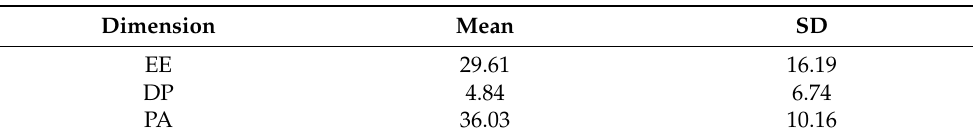
Table 2. Scores of dimensions of Maslach Burnout Inventory-Human Services Survey (MBI-HSS) among village